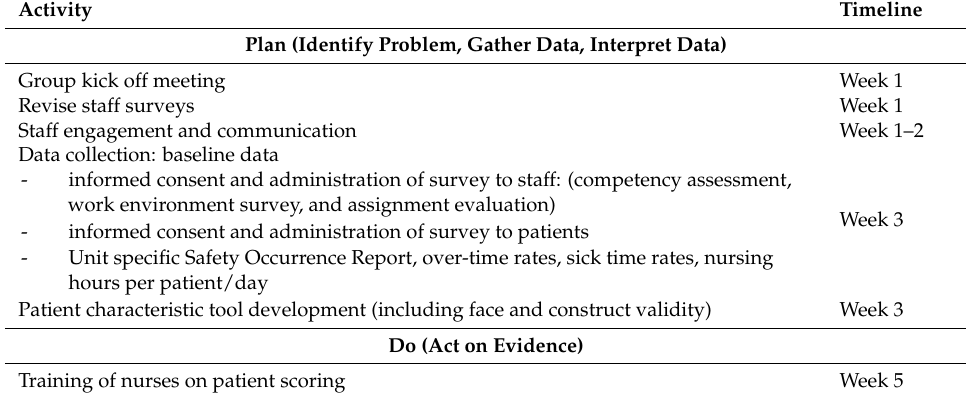
Table A1. Sample timeline using the Plan-Do-Study Act (PDSA)